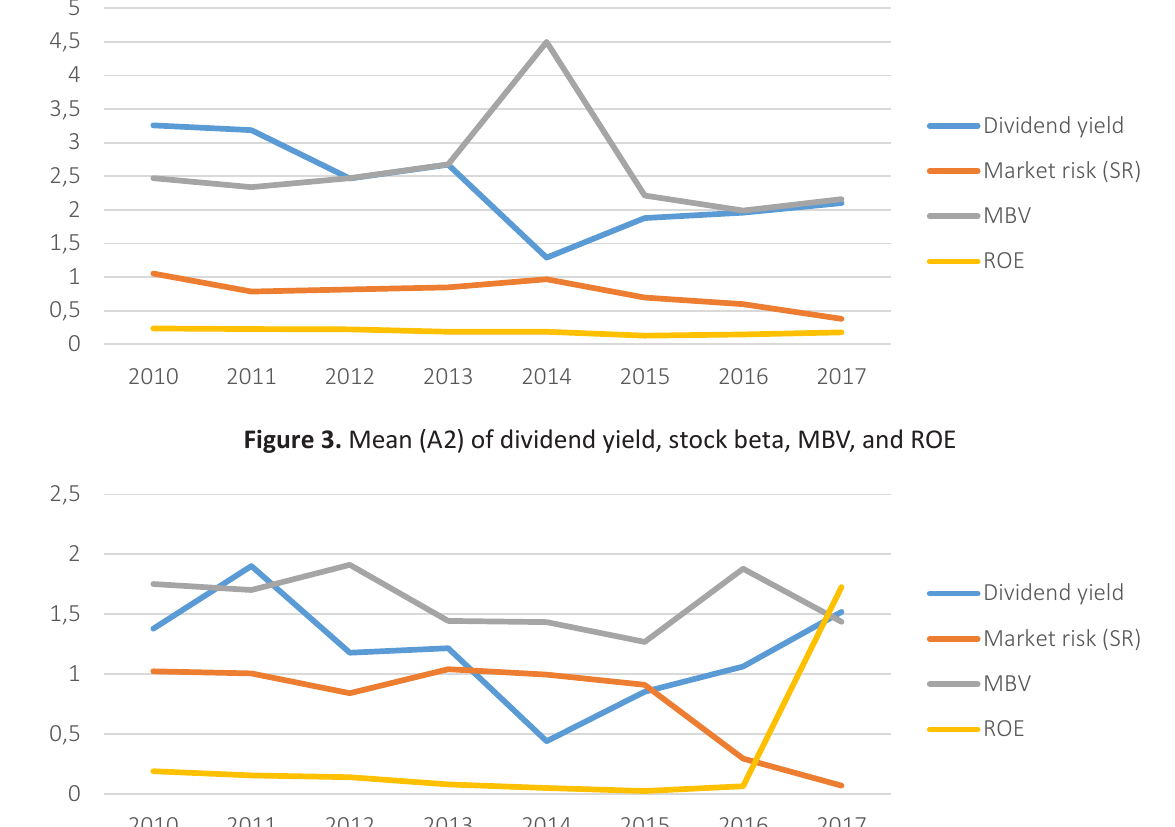
Figure 4. Mean (A3) of dividend yield, stock beta, MBV, and